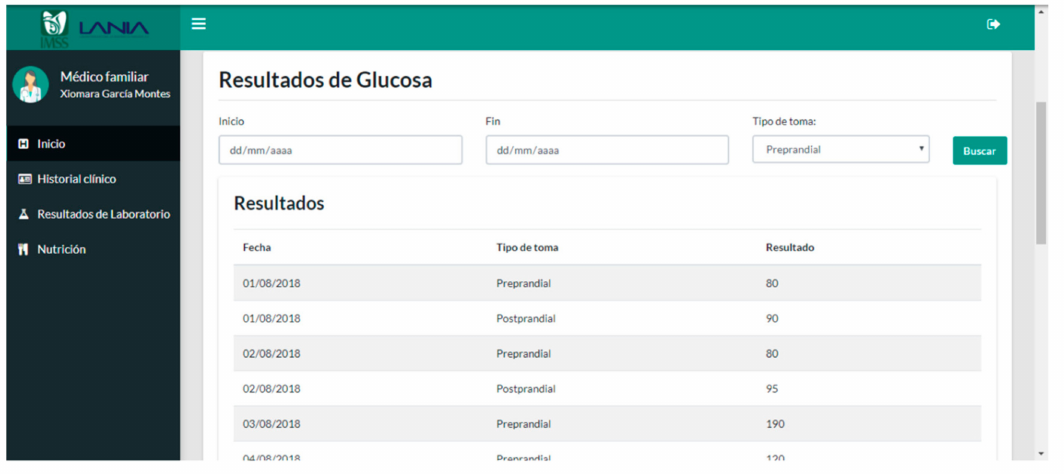
Figure 18. Physician application interface: Glucose